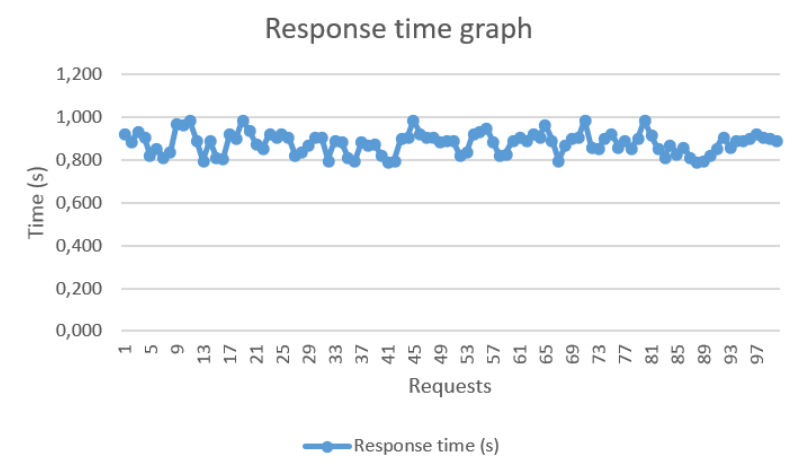
Figure 12. Records of the request/response times captured by pcap